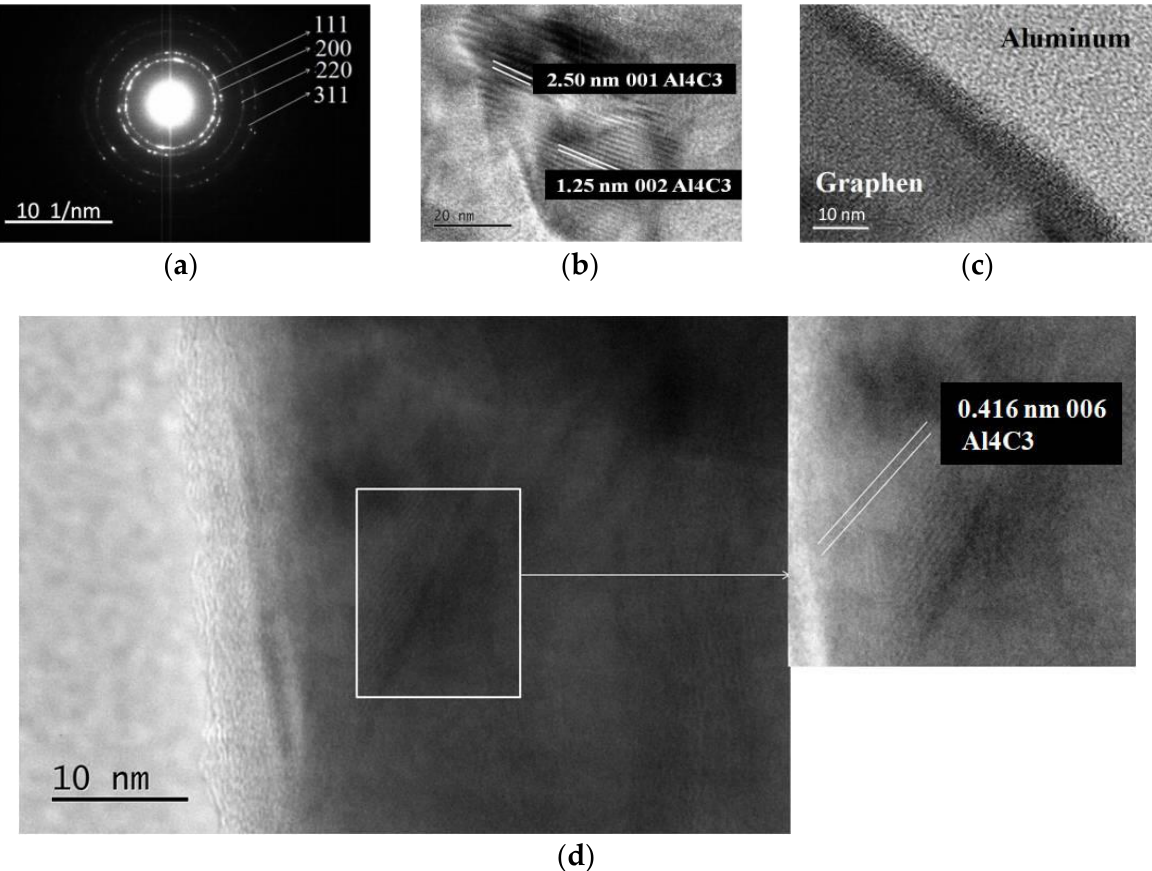
Figure 5. TEM and HRTEM images: ( a ) TEM image in diffraction mode; ( b ) HRTEM image of two areas of Al 4 C 3 crystallographic phase; ( c ) HRTEM image of the interface between nano-sized Al 4 C 3 and the aluminum matrix; ( d ) Fourier filtered HRTEM images of crystallographic phase Al 4 C 3. Figure 6a,b show areas of the longitudinal section of the neck of a tensile-tested specimen. Both broken GNPs and carbide rods (Figure 6a) and semi-pulled out or semi- slipped A 4 C 3 rods from the matrix are observed (Figure 6b) in composites where GNPs were reacted with aluminum matrix and Al 4 C 3 were obtained due to the heat treatment. The failure behavior could be defined as intermediate or mixed—the behavior of breaking the particles and “interface de-bonding and pull-outs”. The fracture behavior of the composites after extrusion is entirely “interface de-bonding and pull-outs” [16,23], which is determined by the presence of a mechanical bond between GNPs and aluminum